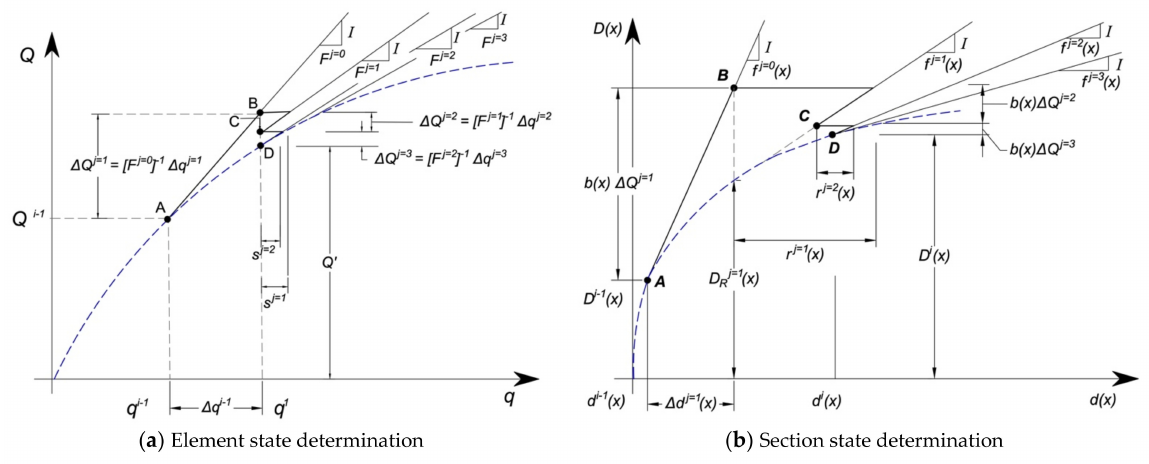
Figure 8. Determination of element resisting forces Q i corresponding to element deformations q i using the element and state determination for a flexibility-based